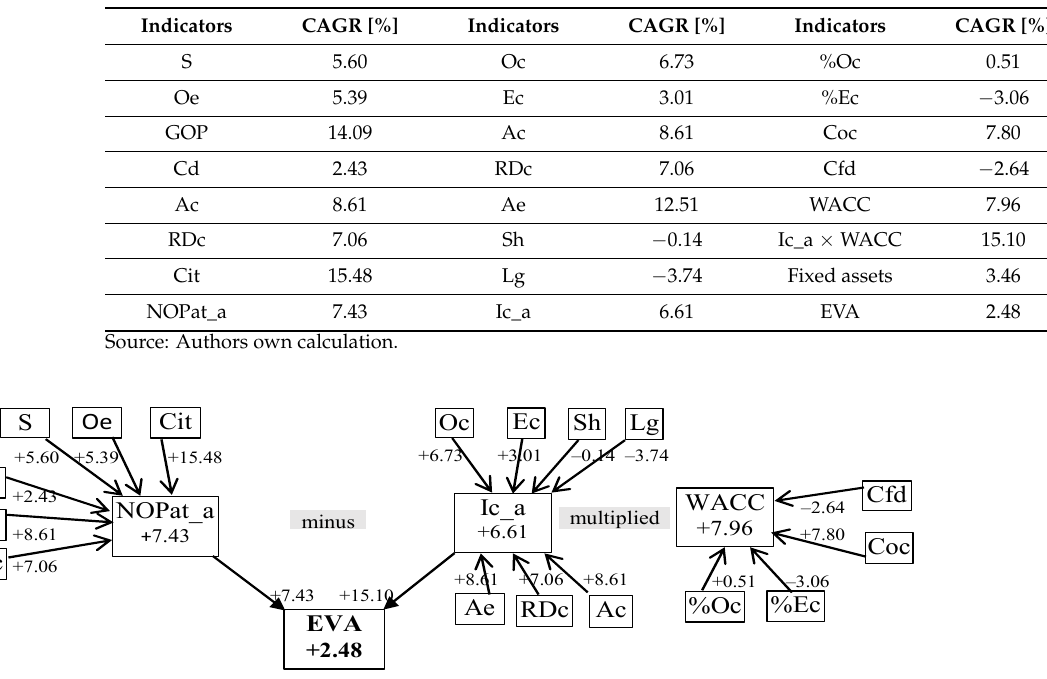
( b ) Figure 2. Trend testing. ( a ) Linear trend lines; ( b ) Polynomial trend lines. Source: Authors own representation. A polynomial trend line indicates that the data vary (as confirmed by previous an- nual analyses), being recommended by the Excel package to describe the relationship be- tween two variables with different trends up to a certain point, beyond which their trends synchronize. Therefore, we can admit that, for the forecast period, the increase of invested capital (adjusted) and net operating profit (adjusted) will generate a higher economic value. These increases will amplify over time, due to operating expenses (such as research and development or promotion) that generate benefits in future financial years. 4.2. Discussions on the Econometric Analysis The invested capital adjusted and ROA are positively and statistically significant re- lated to EVA, according to Model 1. Therefore, an increase of investments in total assets will lead to an increase in EVA. Additionally, higher rates of ROA will determine an in- crease of EVA. These results are in contradiction with previously research results which shown that EVA does not provide information regarding the financial performance of companies affected by variations of business cycles and does not stimulate growth of com- pany wealth (Bhusan Sahoo and Kumar Pramanik 2016). The lack of congruence of the research results is further evidence that this area of research is far from exhausted;